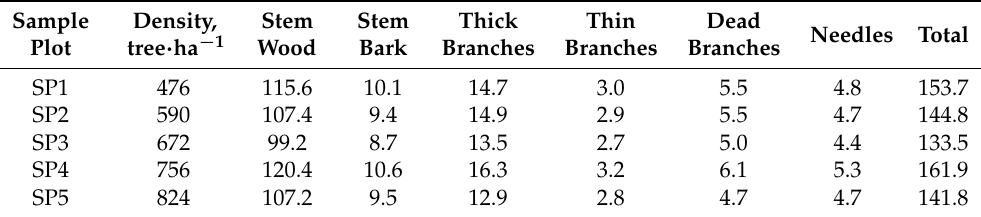
Table 2. Aboveground biomass (Mg · ha − 1 ) of different compartments of five sampled Scots pine stands.